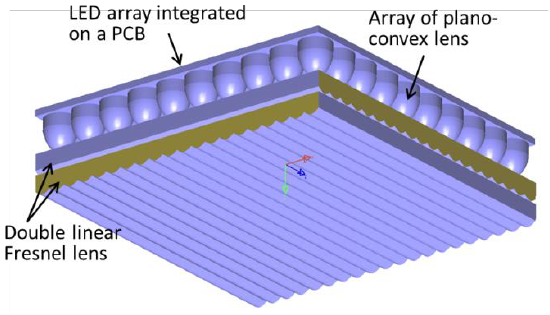
Figure 1. Physical layout of the uniform illumination system for a light-emitting diode (LED) array.